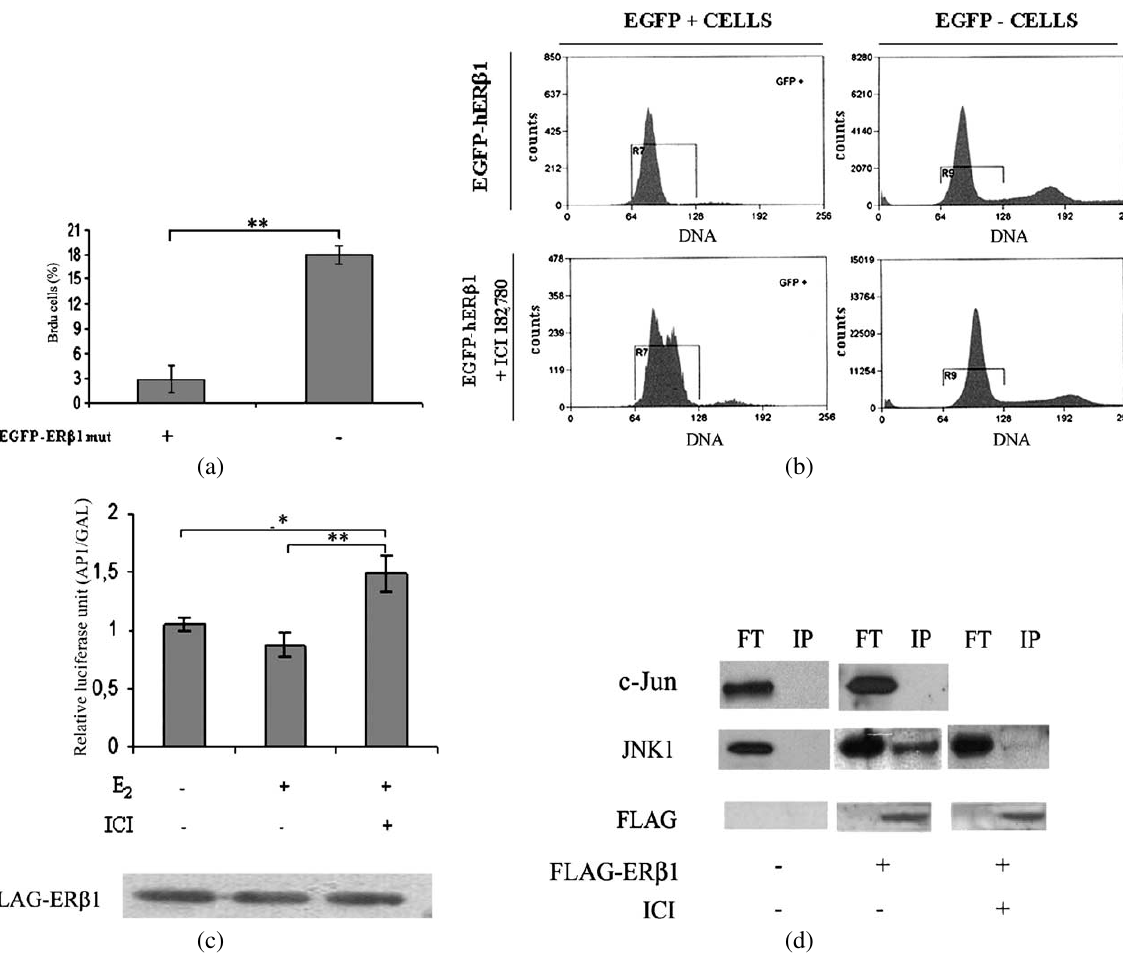
Fig. 7. Mechanism of action of over-expressed ER β 1 on G1 cell cycle phase. (a) Flow cytometric analysis of BrdU incorporation in LNCaP cells, transfected with the EGFP-ER β 1 EG167/168AA mutant vector, showed a significant decrease in the number of BrdU positive cells compared to non-transfected cells of the same culture dish. (b) Cell cycle analysis of EGFP-ER β 1 transfected cells incubated with or without ICI confirmed that ER β 1 over-expressing cells were arrested in early G1 (upper left) compared to non-transfected cells of the same culture dish (upper right), and that ICI induced an arrest in late G1 (lower left), compared to control cells (lower right). (c) Luciferase activity in cells co-transfected with AP1-Luc reporter and FLAG-ER β 1 vector and treated with E2, ICI or both, showed that ICI increased significantly endogenous AP-1 transcriptional activity. (d) Immunoprecipitation of FLAG-ER β 1 transfected and non-transfected cells with an anti-FLAG antibody, followed by western blot analysis of c-Jun and JNK1 of the immunoprecipitated (IP) and flow throw (FT) fractions, demonstrated that ER β 1 interacted with JNK1 and that this interaction was abolished by